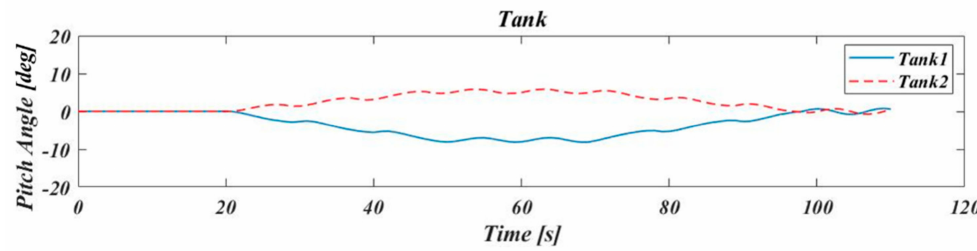
Figure 10. Time series of the corresponding pitch angles in the forward and aft ballast tanks,